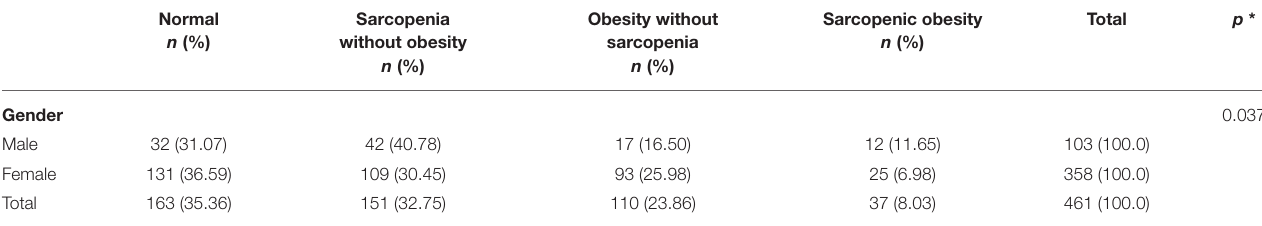
TABLE 2 | Distribution of the four body composition categories by gender.